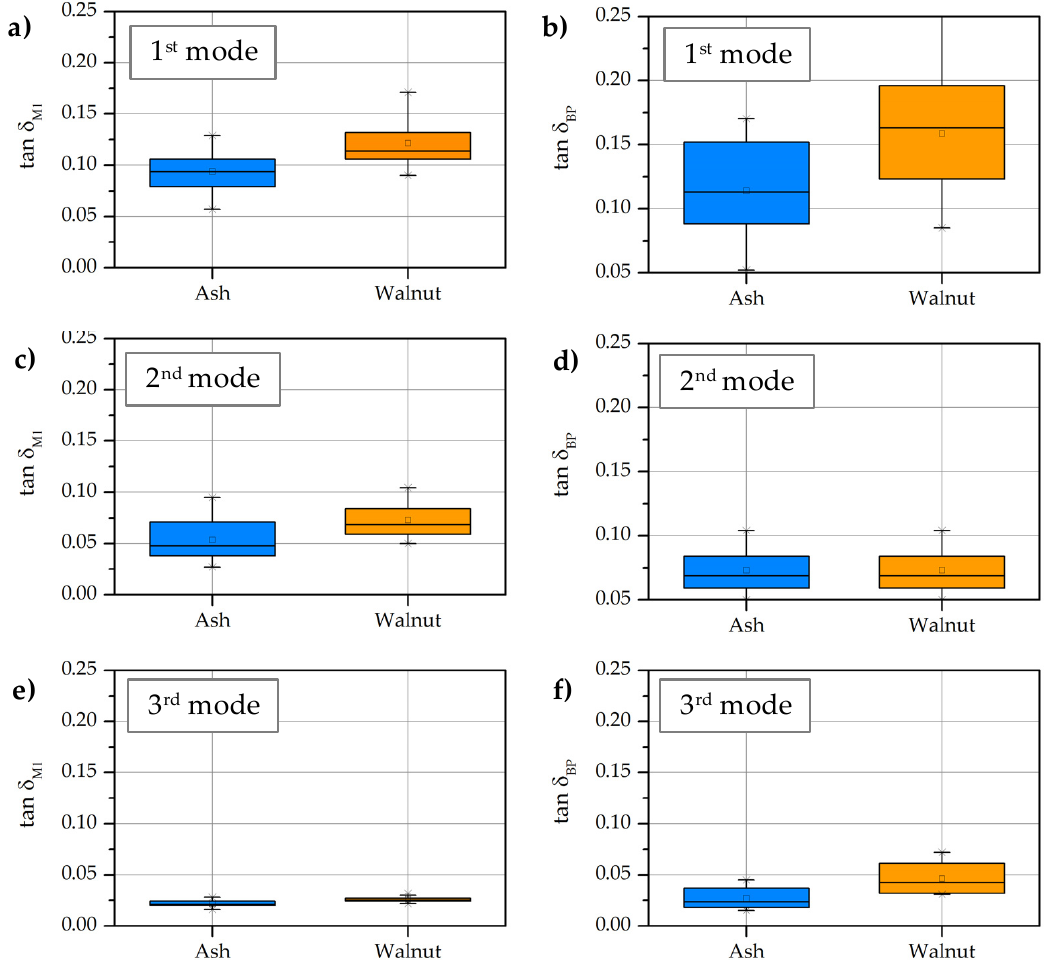
Figure 4. Vibration damping of guitar body made from ash and walnut wood in 1st, 2nd and 3rd vibration mode: ( a , c , e )—signal acquisition with body microphone (M 1 ); ( b , d , f )—signal acquisition with body pickup (BP) [(ash wood ( ● ); walnut wood ( ● )].